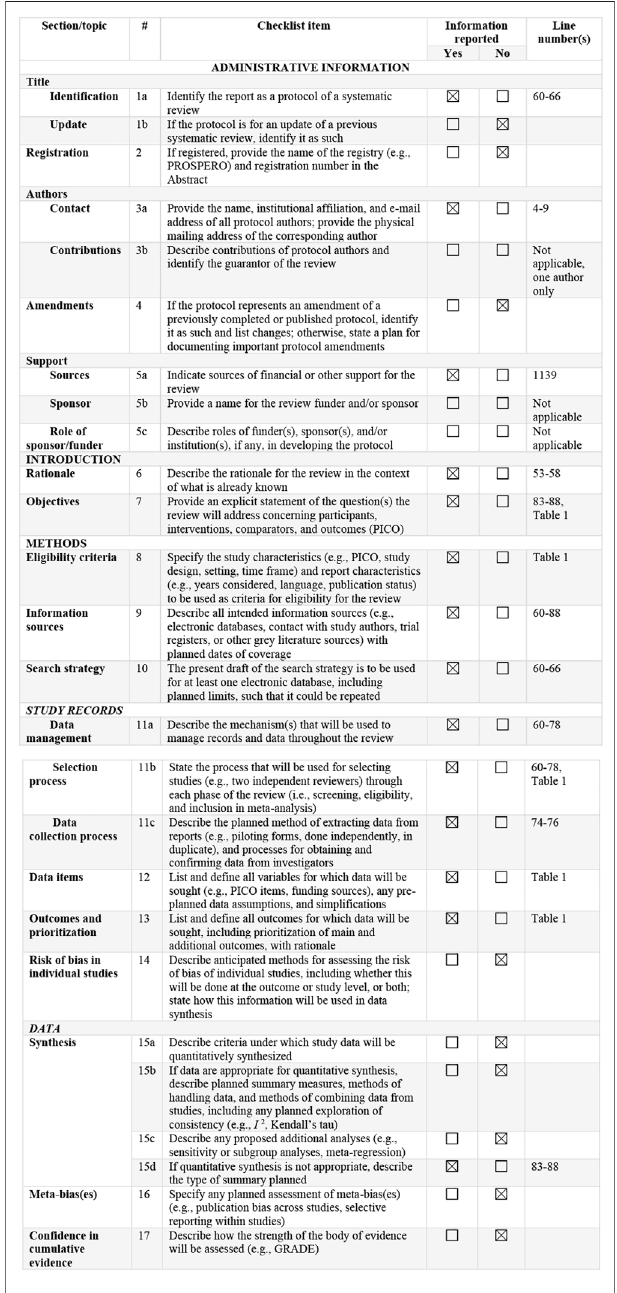
FIGURE 1 | PRISMA-P 2015 Checklist (Moher et al., 2015). This checklist has been adapted for use with protocol submissions to systematic reviews from Table 3 in Moher D et al.: preferred reporting items for systematic review and meta-analysis protocols (PRISMA-P) 2015 statement. Systematic Reviews 2015